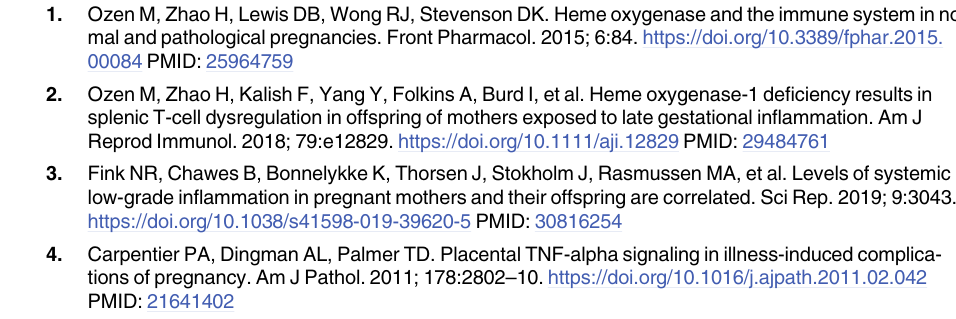
S3 Fig. Expression of immune genes in Wt placentas 24 hrs after LPS90 treatment. Using PCR arrays, we observed a significant upregulation of tumor necrosis factor receptor 1-alpha (Tnfrs1 α ) expression in Wt placentas (n = 3) 24 hrs after LPS90 compared with Wt control placentas (n = 3, p = 0.021). (TIFF) S1 Table. Body weights of Wt and Het dams with or without LPS treatment at E15.5 and E16.5. LPS90 was administered i.p., at E15.5 to pregnant (P) Wt and Het dams. LPS90-treated Wt dams did not lose weight at E16.5 (n = 18) compared with age-matched pregnant Wt dams (n = 6). LPS90-treated Het dams did not lose weight at E16.5 (n = 8) compared with age- matched pregnant Het dams (n = 7 for both embryonic ages). p > 0.05.